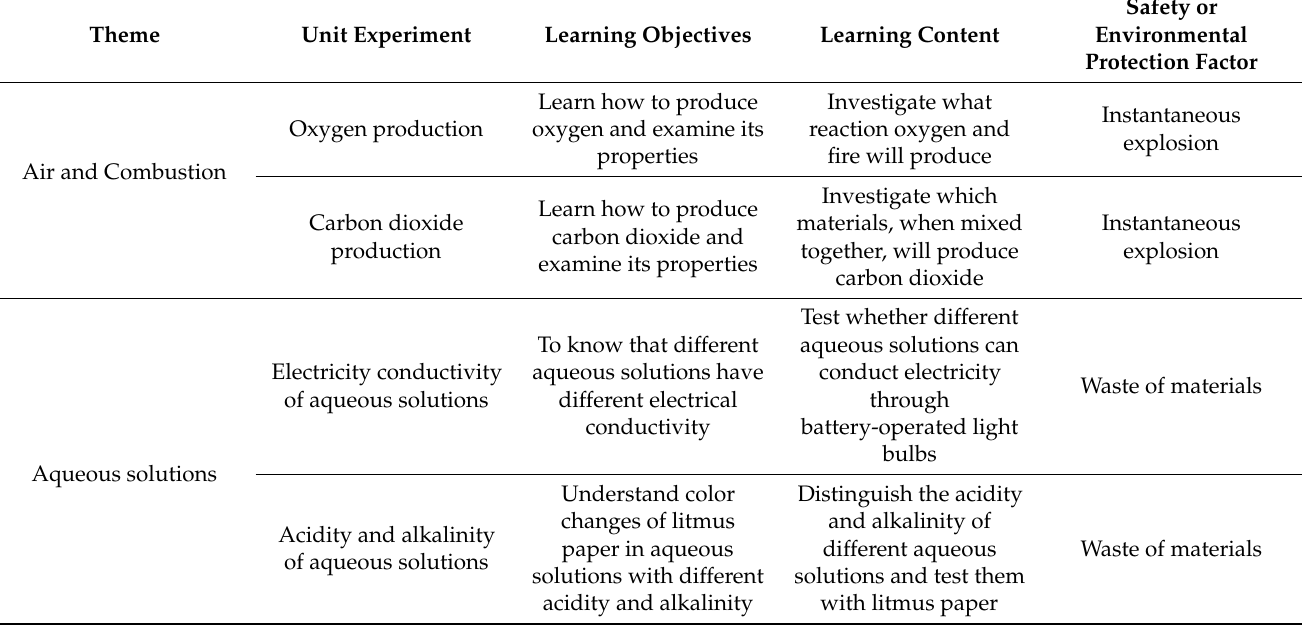
Table 4. Planning table of Natural Science and Living Technology Curriculum experimental curriculum.